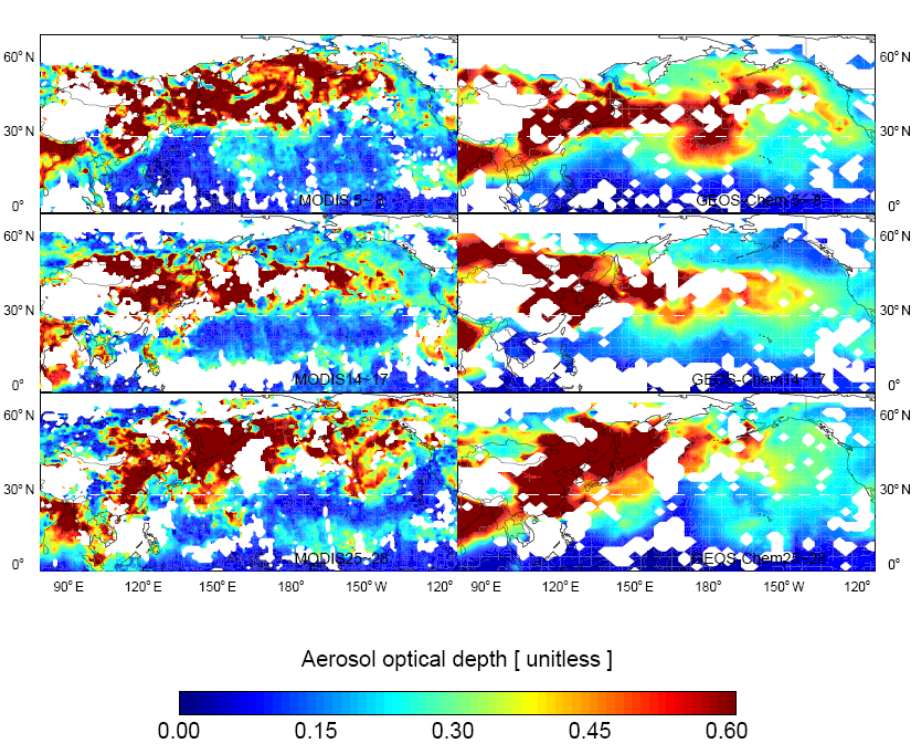
Fig. 1. AOD at 550nm over the Pacific during 5–8 (first row), 14–17 (second row), and 25–28 (third row) of May 2003 observed by MODIS (first column) and simulated by GEOS-Chem (second